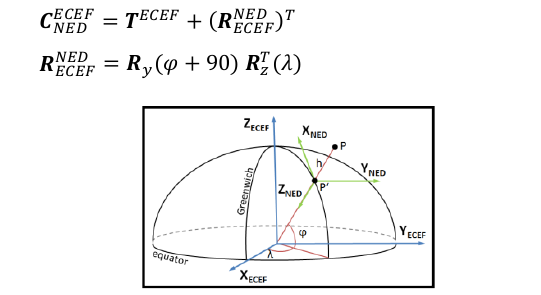
Figure 5. Relation between navigation (green) and ECEF coordinate system